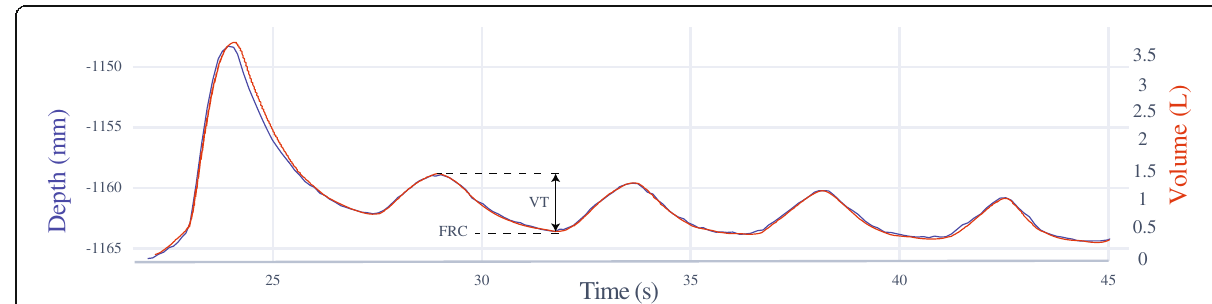
Fig. 5 Supine position. Superimposed graphs of mean depth, measured by the Kinect ( blue , left axis) and volume, measured with spirometry ( red , right axis) of a volunteer in the supine position. Periods of breath-hold are indicated with grey boxes . FRC functional residual capacity, VT tidal